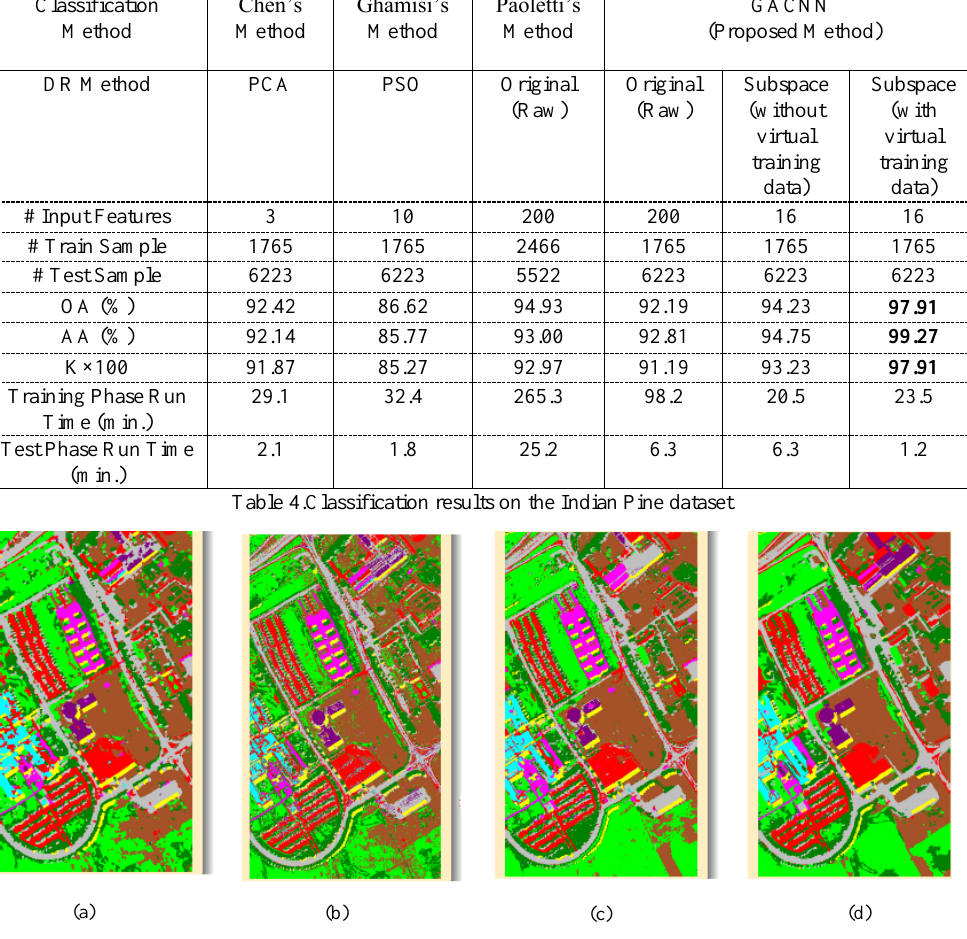
Table 4.Classification results on the Indiana Pine dataset